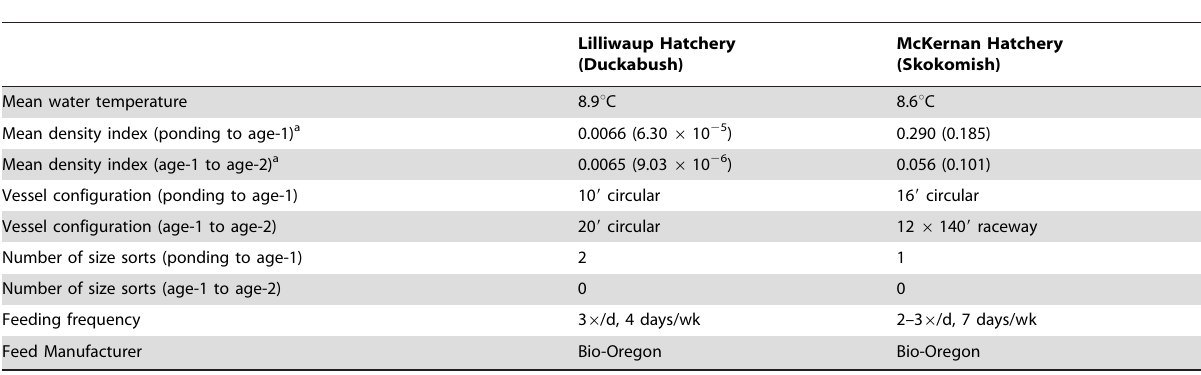
Table 2. Hatchery conditions and practices.